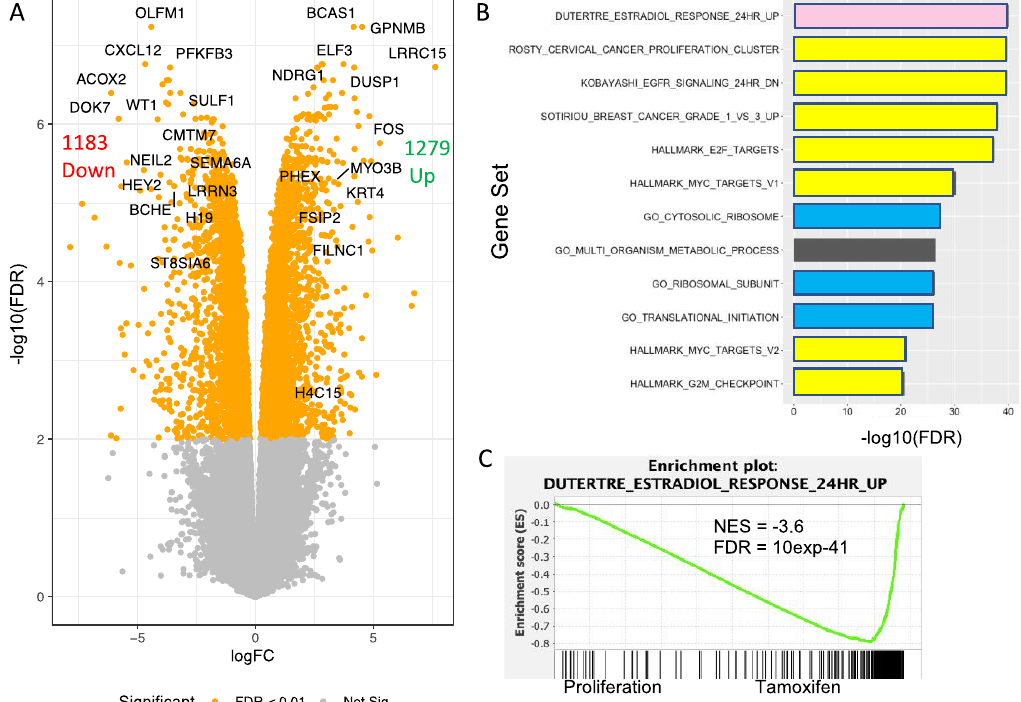
Figure 10. Genes differentially expressed upon treatment of T47D cells with tamoxifen. ( A ) Volcano plot of log fold-change (logFC) versus -log10 of the false discovery rate (FDR) for genes differentially expressed in proliferating versus tamoxifen- treated T47D cells. Orange dots represent genes with FDR < 0.01. The indicated genes are those with log2 fold changes of +/− 3 and an average expression of greater than 1 in the limma–voom analysis. ( B ) Enrichment analysis indicating significant correlations of genes differentially expressed upon tamoxifen treatment with gene sets involved in estradiol response (pink), breast cancer or cell proliferation (yellow), protein synthesis (blue), and metabolic process (black). ( C ) Enrichment plot of tamoxifen-regulated genes compared to the c2 gene set “Dutertre_Estradiol_Response_24HR_UP” [37,38]. NES (normalized enrichment score).